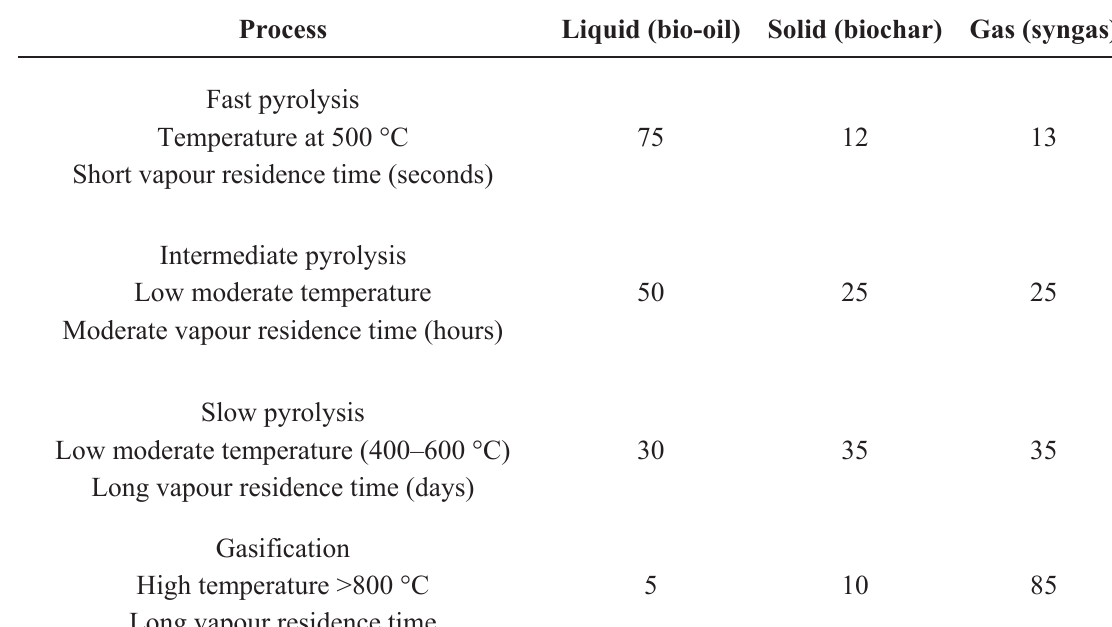
Table 1. Fate of initial feedstock mass in percentage (%) between products of pyrolysis processes